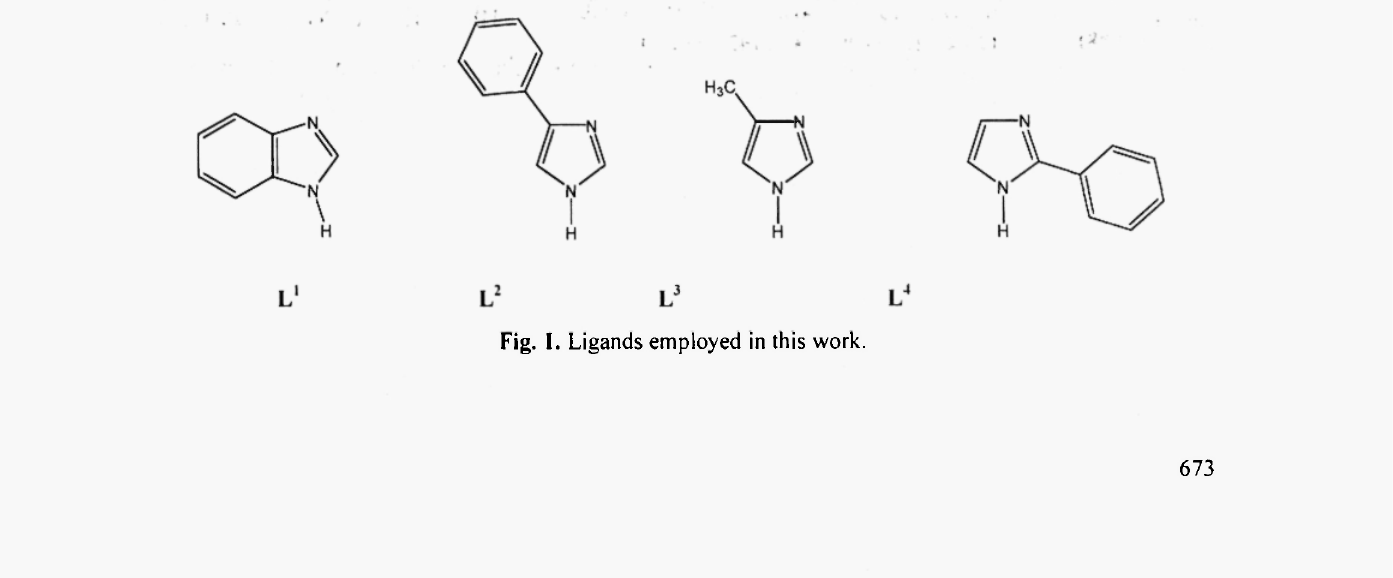
Fig. I. Ligands employed in this